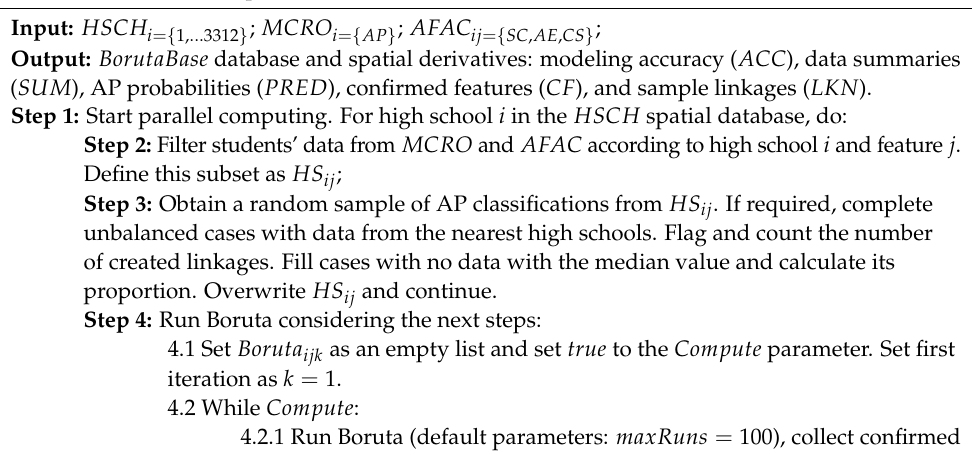
Algorithm 1: Boruta implementation for the BCH